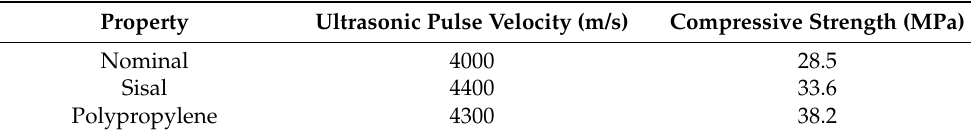
Table 4. Ultrasonic pulse velocity (m/s) and Compressive strength